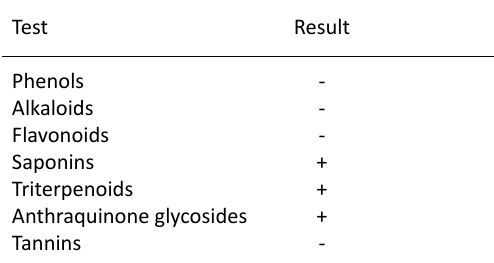
table 1. Screening of metabolites compound results